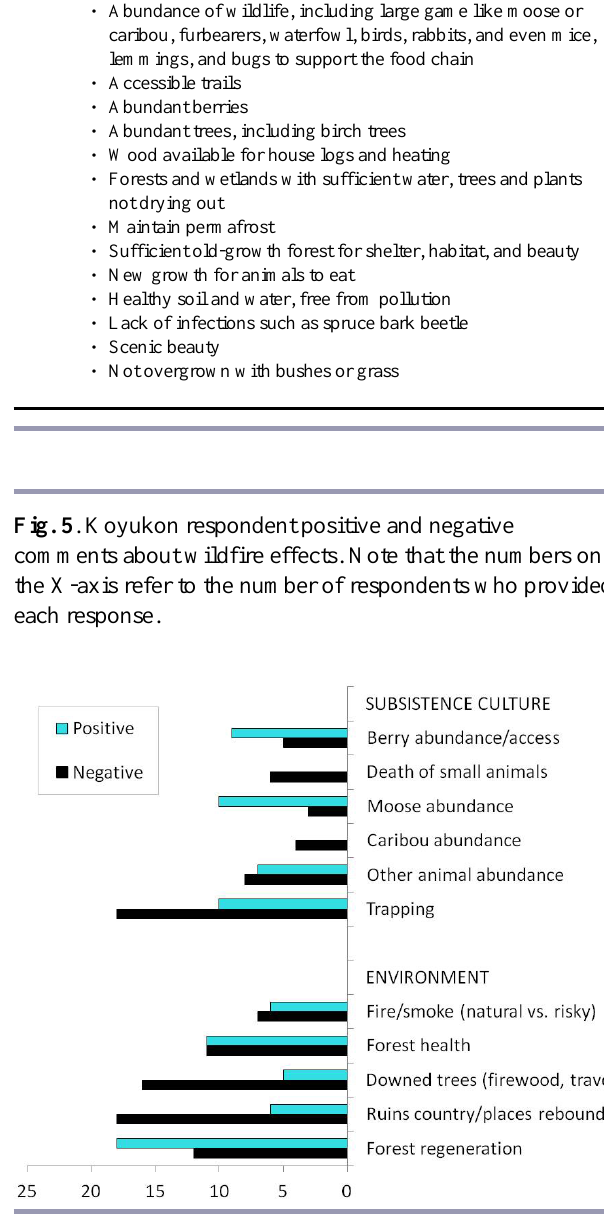
Fig. 4 . Specific drivers (Column 1) of landscape-scale flammable conditions (Column 2) as reported by Koyukon respondents. Jack spruce refers to small, densely clustered black spruce ( Picea mariana ). Note that the numbers in parentheses refer to the number of respondents who provided that response.